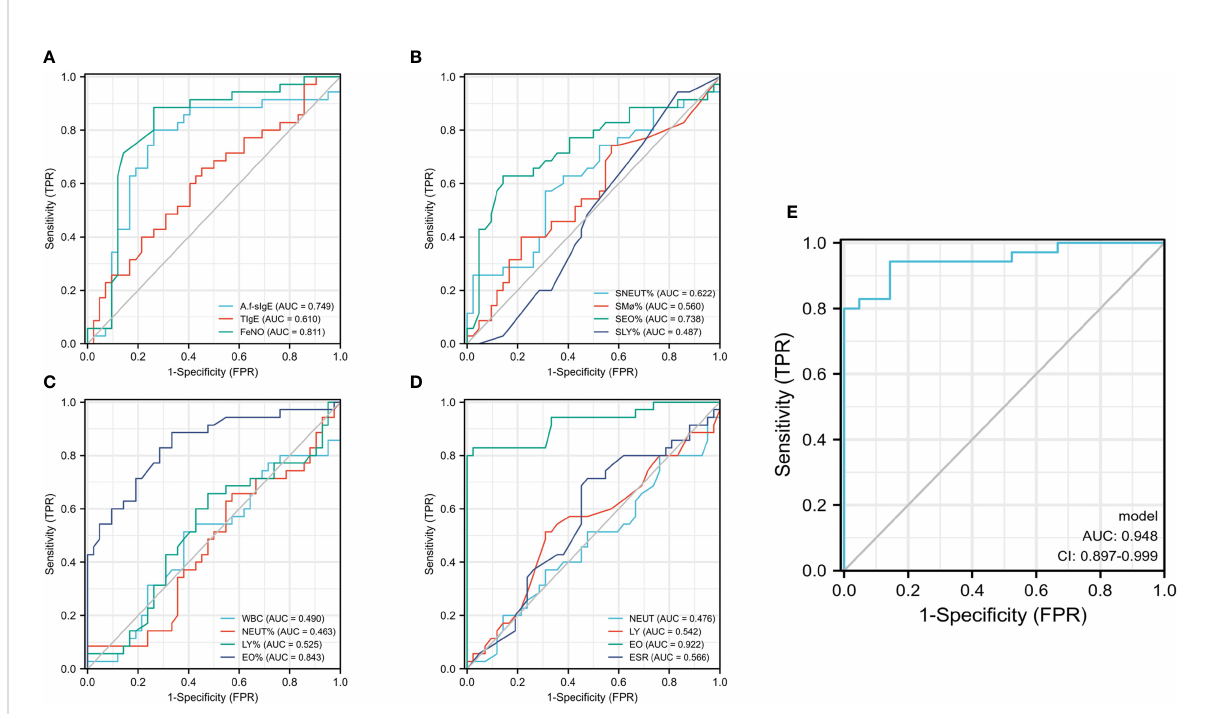
FIGURE 5 Predictive value of clinical parameters in A.f (+) asthma and ABPA. A.f (+) asthma, Aspergillus fumigatus -sensitized asthma; ABPA, allergic bronchopulmonary aspergillosis. (A – D) ROC curve analyzed the predictive value of clinical parameters for A.f (+) asthma and ABPA; (E) ROC curve analyzed the predictive value of combination of FeNO and EO parameters.